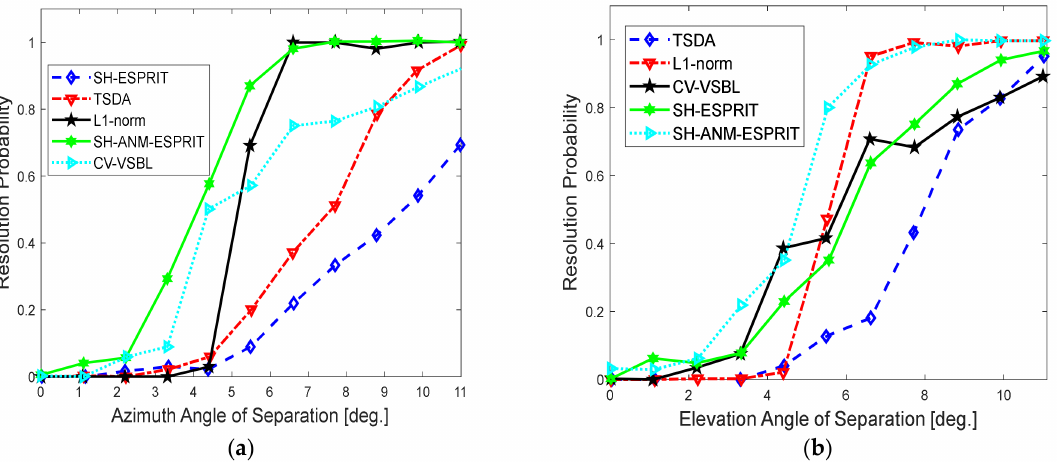
Figure 5. Resolution probability against angle of separation under uncorrelated sources at ( θ , ϕ ) = ( 40 ◦ ,60 ◦ ) and ( 40 ◦ + ϑ ,60 ◦ + ϑ ) , 3 dB SNR. ( a ) Azimuth. ( b )